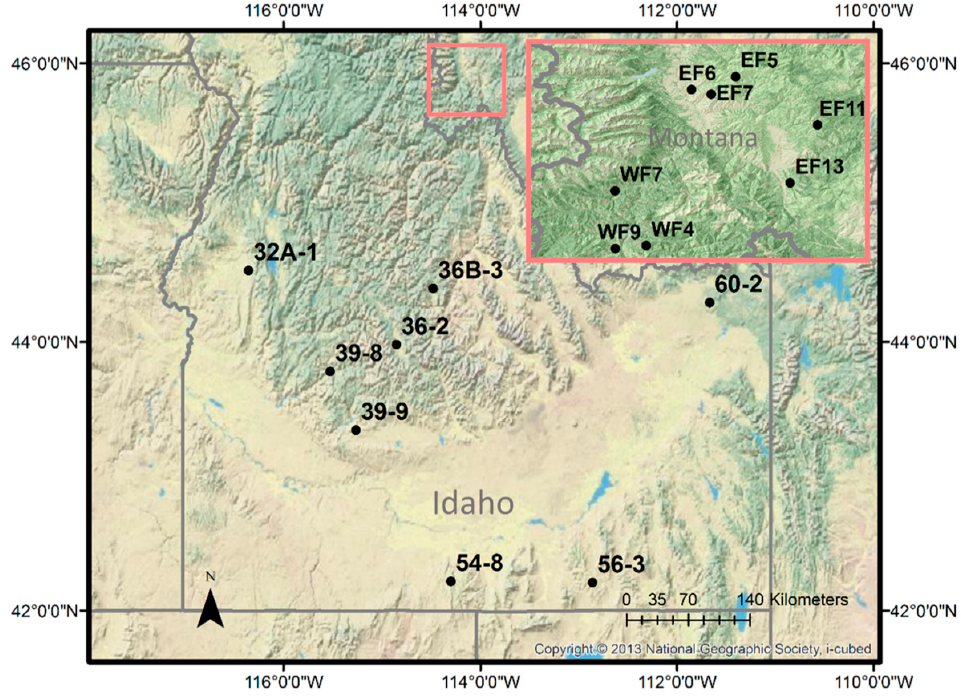
Figure 1. The location of camera network sites in our study. Idaho sites are across central and southern portions of the state. Montana sites are concentrated in the southern end of the Bitterroot Valley of Southwestern Montana. The inset map is close up view of the area highlighted in the map.